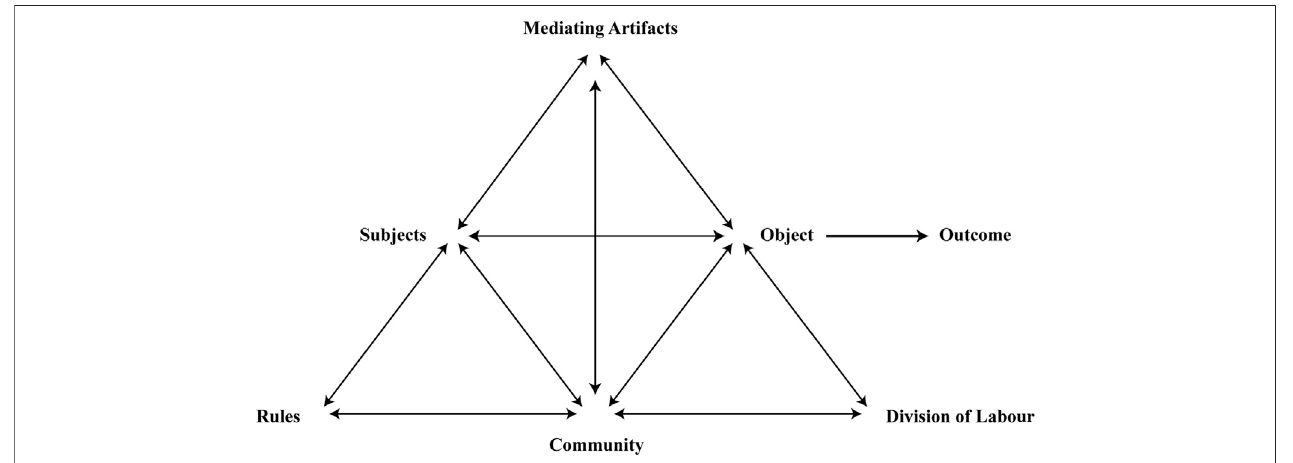
FIGURE 1 | The complete activity system (Engeström,